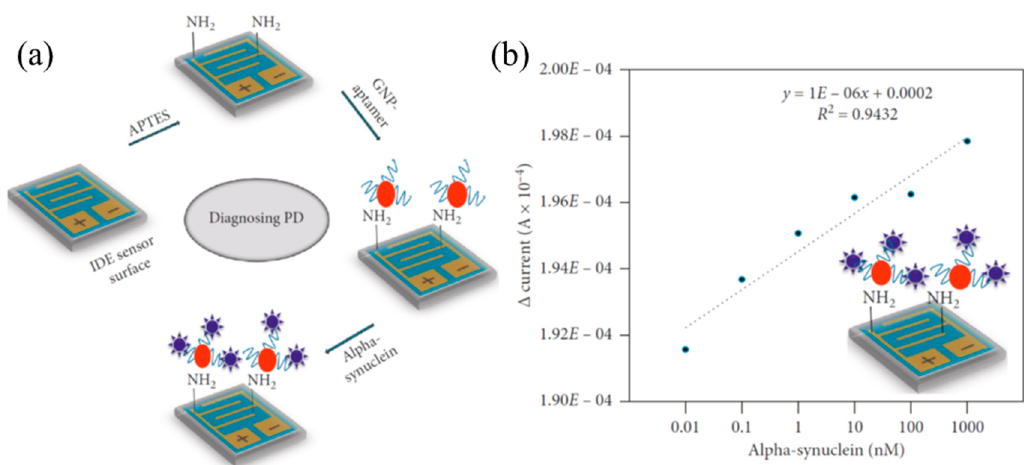
Figure 12. ( a ) Schematic illustration of the surface functionalization steps of the IDE sensor for detecting α -synuclein. First, the surface is modified by APTES to immobilize the GNP-aptamer, then alpha-synuclein is detected. ( b ) The measured responses of α -synuclein of different concentrations, and the linear regression analysis. The limit of detection is 10 pM. Reproduced from reference [100] with permission from Hindawi Publishing Corporation.